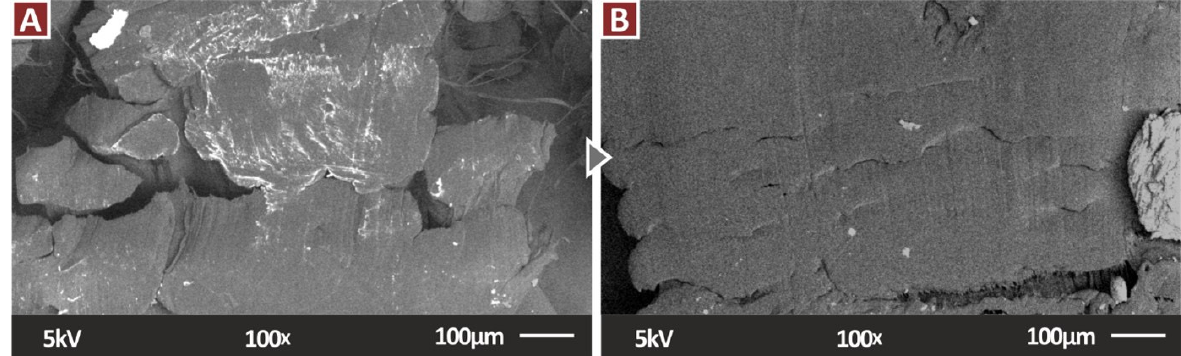
Figure 7. Images taken on unfilled HDPE 3D-printed tensile test samples with SEM ( A ) fracture region and ( B ) side area.